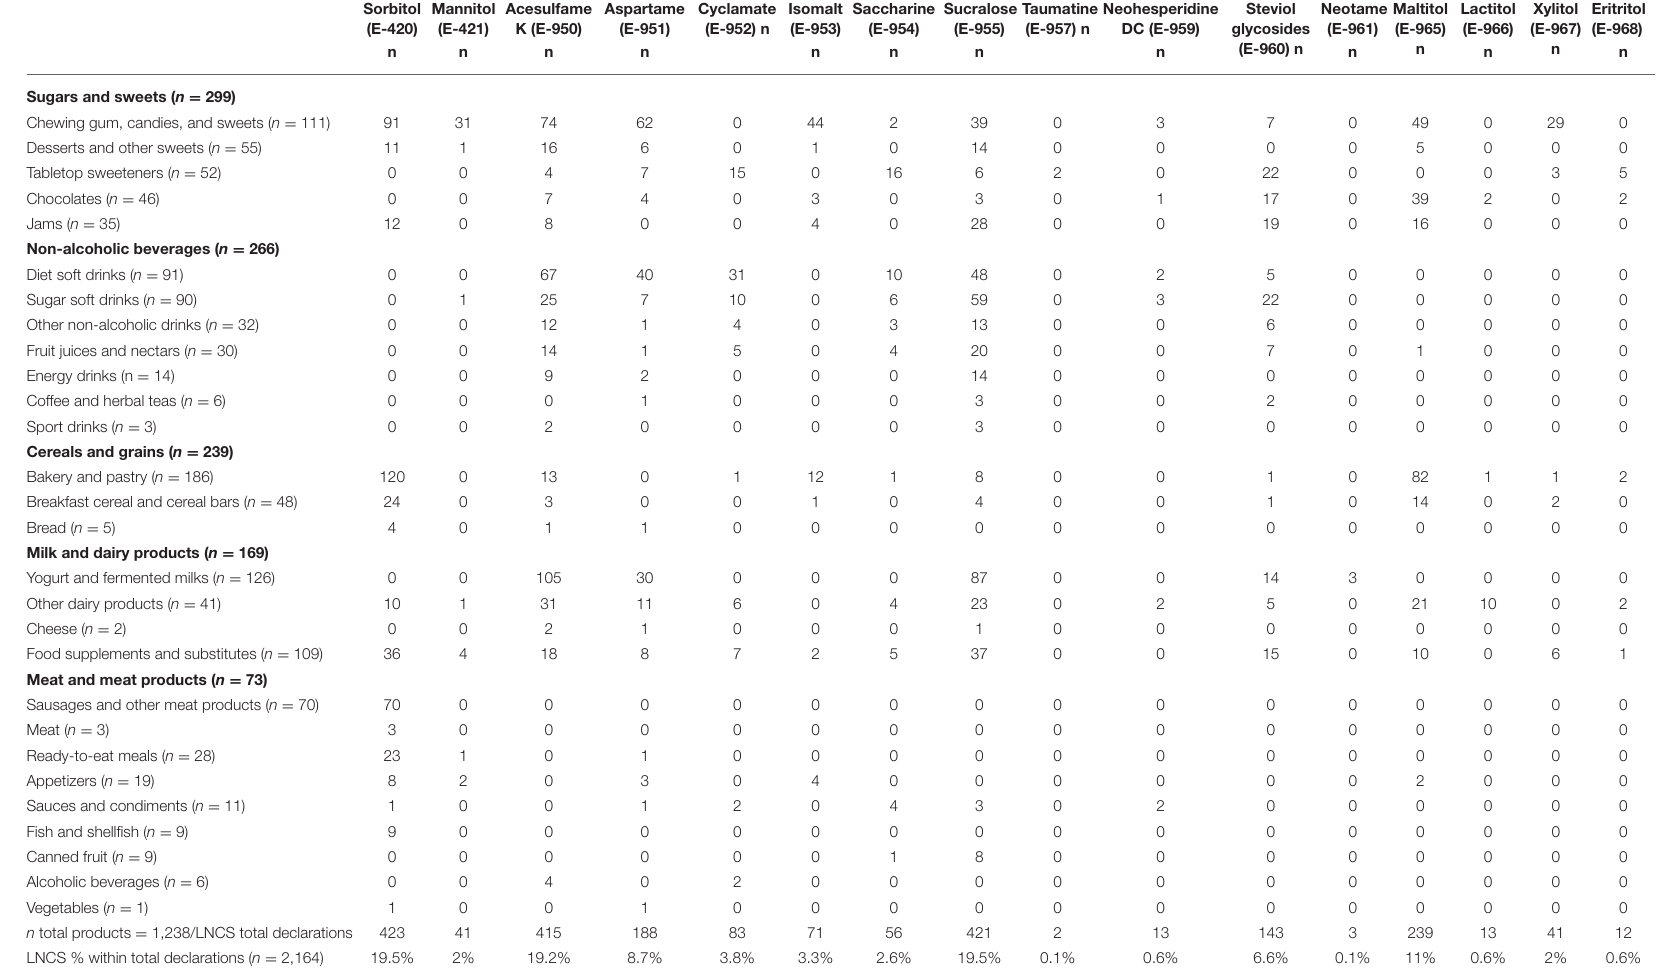
TABLE 2 | Declared types and distribution (n) of LCNS across assessed food groups and subgroups available in the Spanish